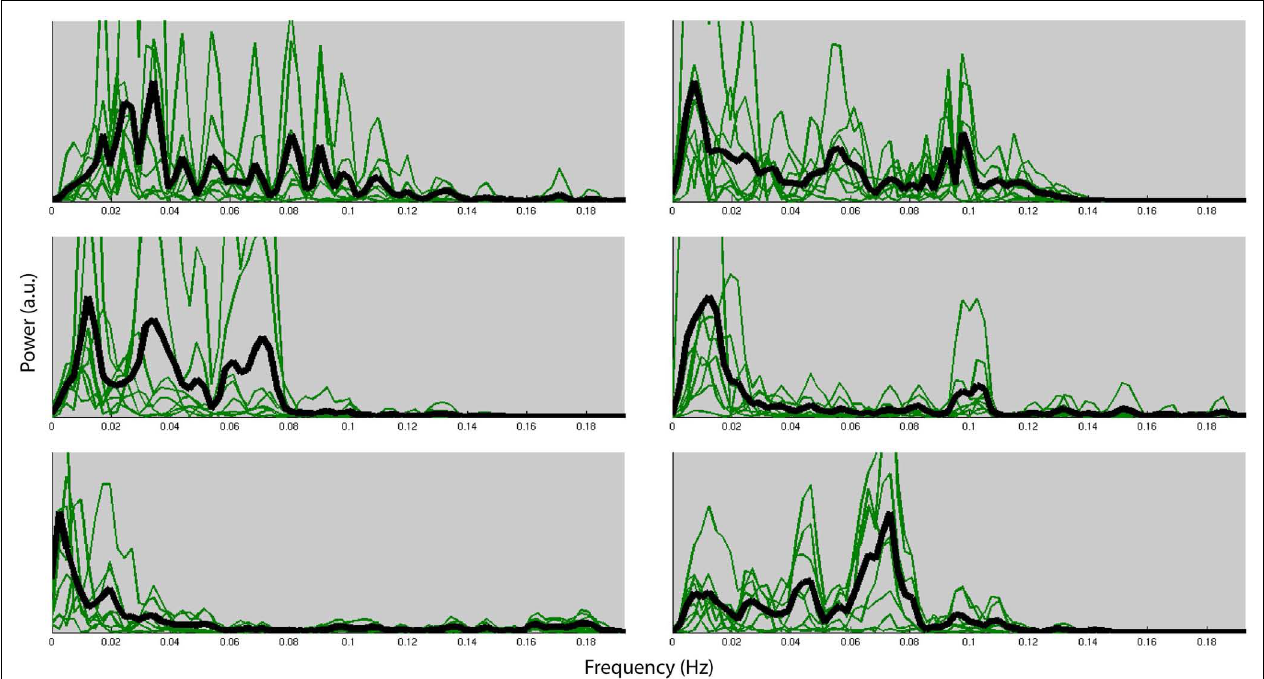
FIGURE 4 | Normalized frequency spectra of all RSNs (in green) and their average (in black) for each of the six subjects up to 0.2Hz .Variation over subjects is much higher than the variation over